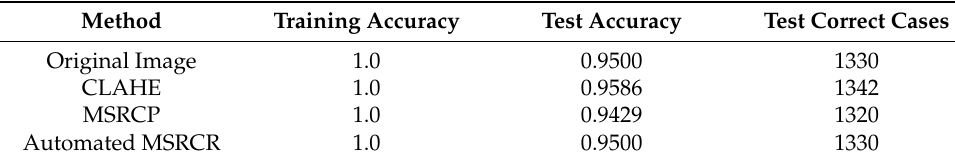
Table 4. Effects of image enhancement methods on RSSCN7 dataset.